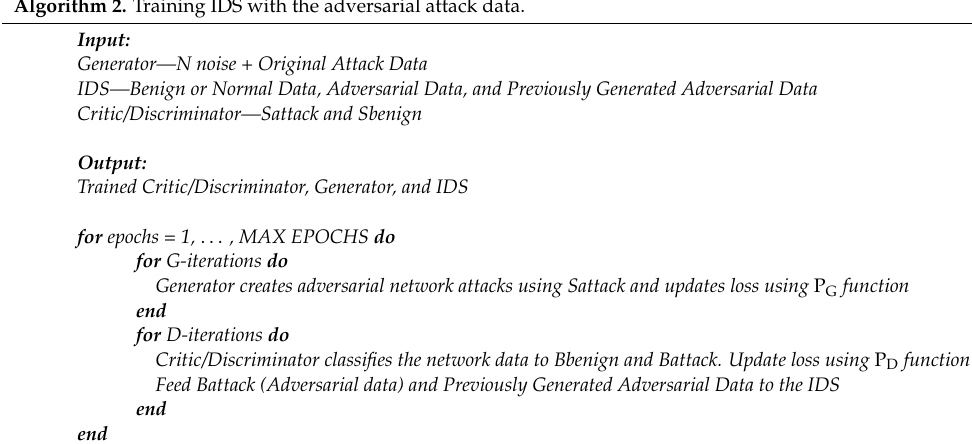
Algorithm 2. Training IDS with the adversarial attack